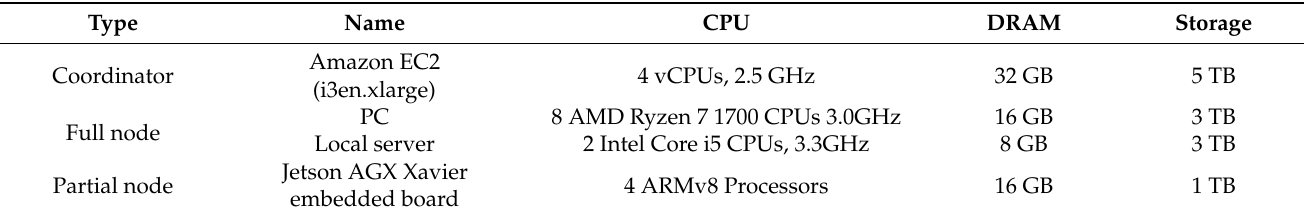
Table 1. Evaluation environment